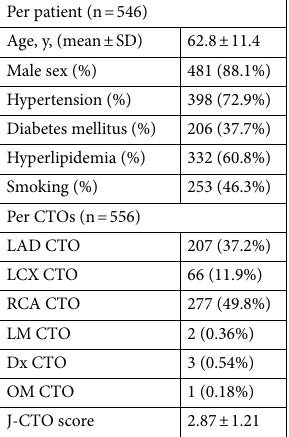
Table 1. Demographic and Target Lesion Characteristics. LAD left anterior descending artery, LCX left circumflex artery, RCA right coronary artery, LM left main coronary artery, Dx diagonal branch, OM obtuse marginal branch, CTO chronic total